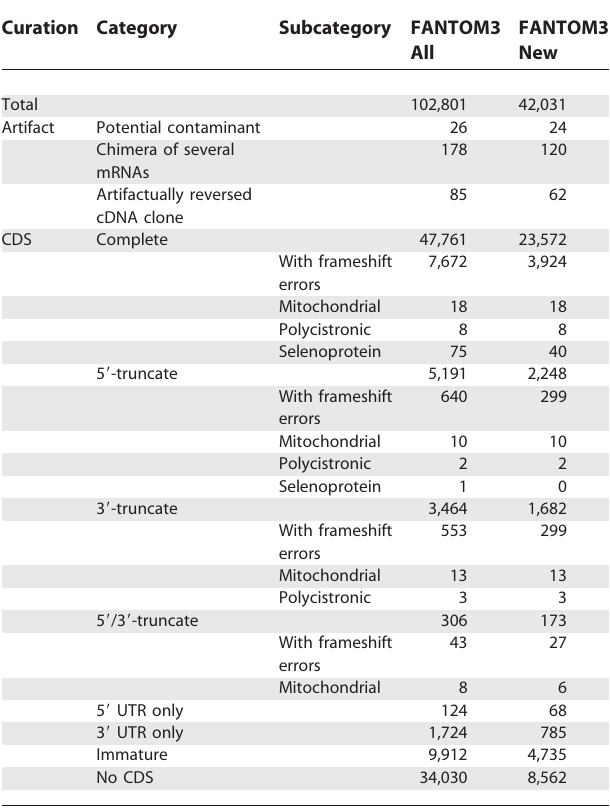
Table 2. Summary of Annotation in FANTOM3 Curation